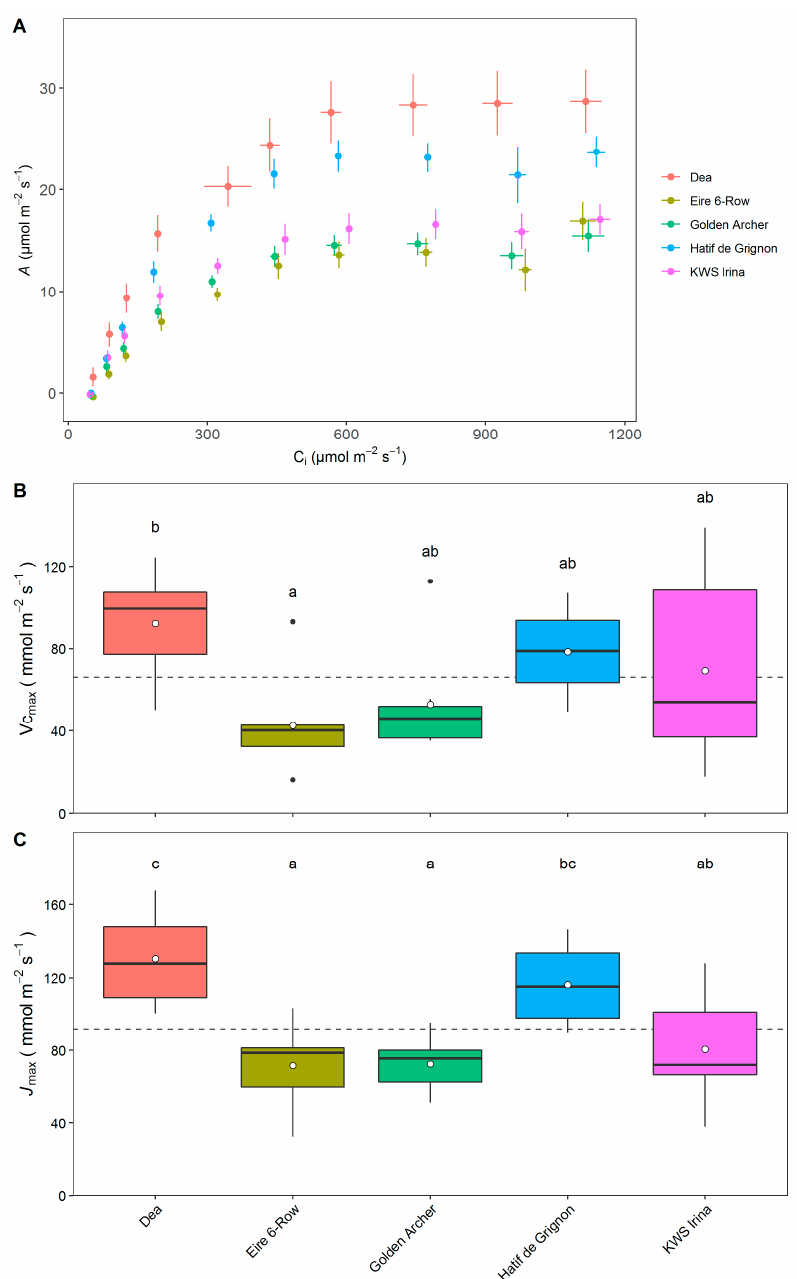
Figure 6. Assimilation responses of 5 barley cultivars (the landraces Dea, Eire 6-Row, Golden Archer and Hatif de Grignon and the elite cultivar KWS Irina) to changing C i . ( A ) A - C i response curves for each cultivar to increasing C i . ( B ) Vc max , the maximum velocity of Rubisco for carboxylation. ( C ) J max , the maximum rate of electron transport demand for Ribulose 1,5 bisphosphate. Data shown in ( A ) are means +/ − se, N = 5 − 6, and box and whisker plots in ( B ), ( C ), where white points indicate the mean. Identical letters indicate no significant differences between means based on Tukey’s test of model outputs at p =